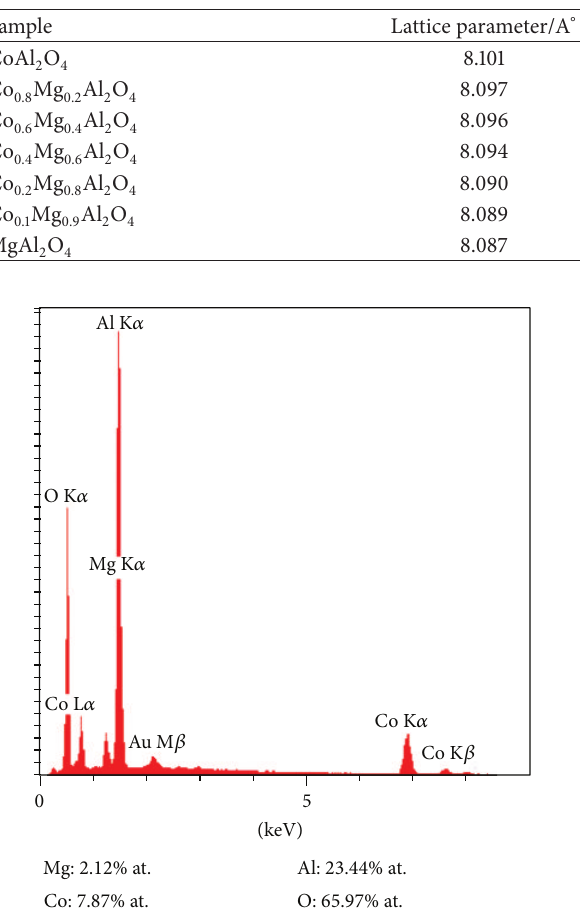
Figure 3: X-ray emission pattern of Co 0.8 Mg 0.2 Al 2 O 4 powder and its elemental composition.